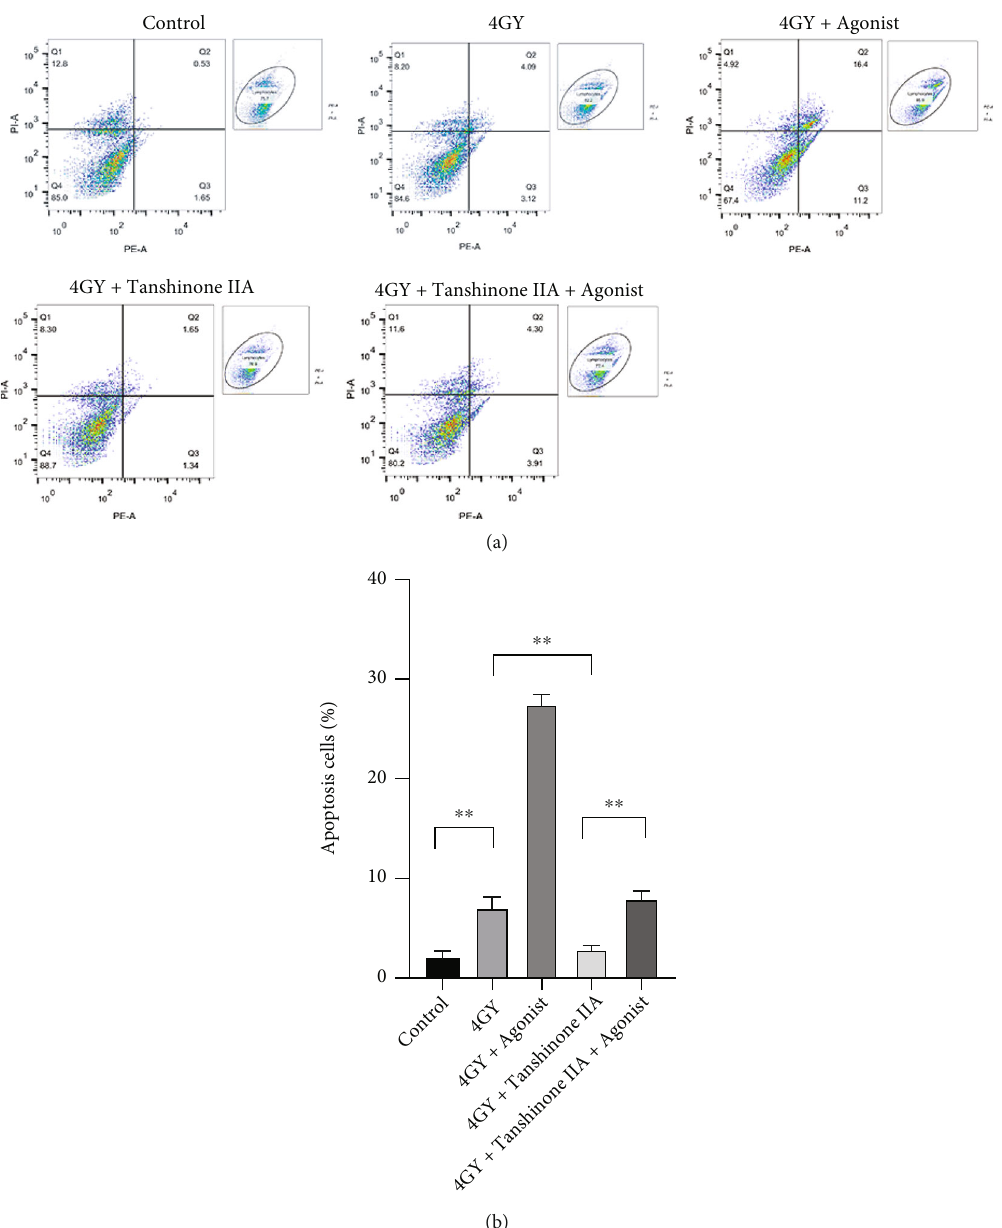
Figure 4: E ff ects of radiation and tanshinone IIA on cardiomyocyte apoptosis. (a) Flow cytometry was used to detect apoptosis in each group. (b) The results are expressed as mean ± SD ( n = 3 ). ∗∗ P < 0 : 01